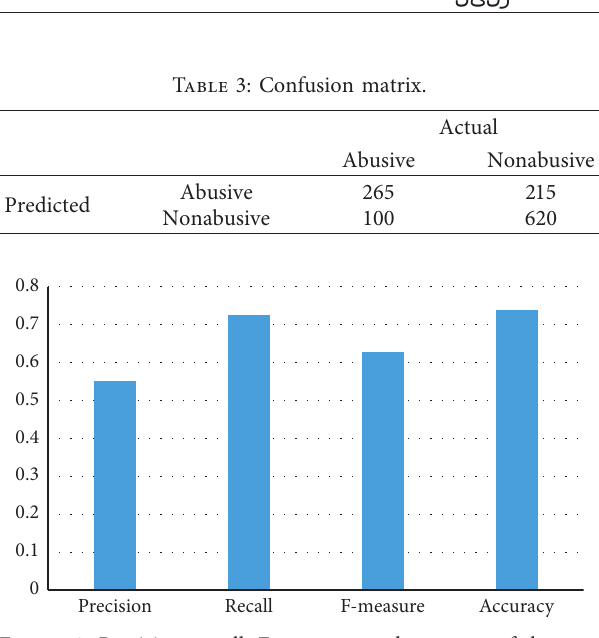
Figure 3: Precision, recall, F-measure, and accuracy of the pro- posed USAD